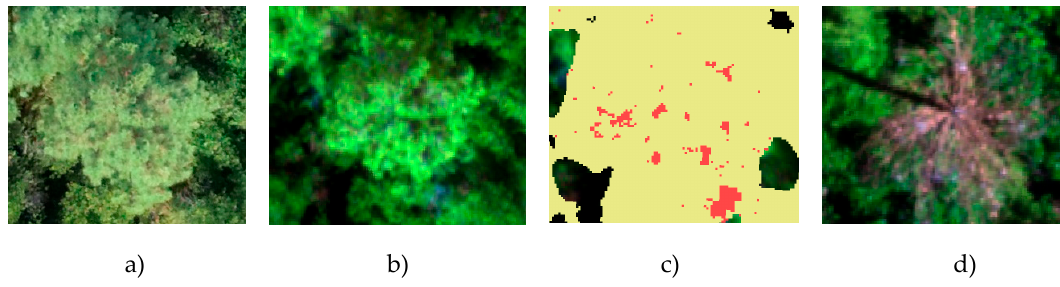
Figure 13. Early detection of the infected tree: ( a ) RGB—October 2018 (from the RGB camera): note that no symptoms are visible to the naked eye; ( b ) RGB representation (from the MS data); ( c ) classification map; ( d ) dead tree in June 2019 (RGB camera). Color code of classified pixels: blue = infected, red = suspicious, yellow = healthy.